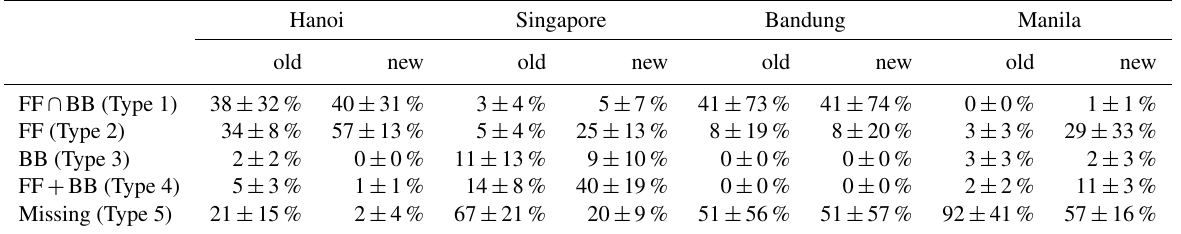
Table 5. The old (without missing anthropogenic aerosol components) and new (with missing anthropogenic aerosol components in FF and FFBB) calculated percentage of observed LVDs, categorized according the type classification explained in Fig. 2. Hanoi Singapore Bandung Manila old new old old old new